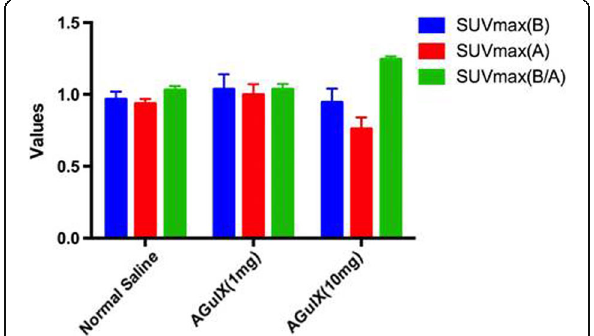
Fig. 5 18 F-FDG PET quantitative evaluation before and after irradiation. T/L (B), the ratio of SUVmax (tumor) to SUVave (liver) before irradiation; T/L (A), the ratio of SUVmax (tumor) to SUVave (liver) after irradiation; T/L (B/A), the ratio of T/L (B) to T/L (A); AGuIX (1 mg), 1 mg of AGuIX injected; AGuIX (10 mg), 10 mg AGuIX